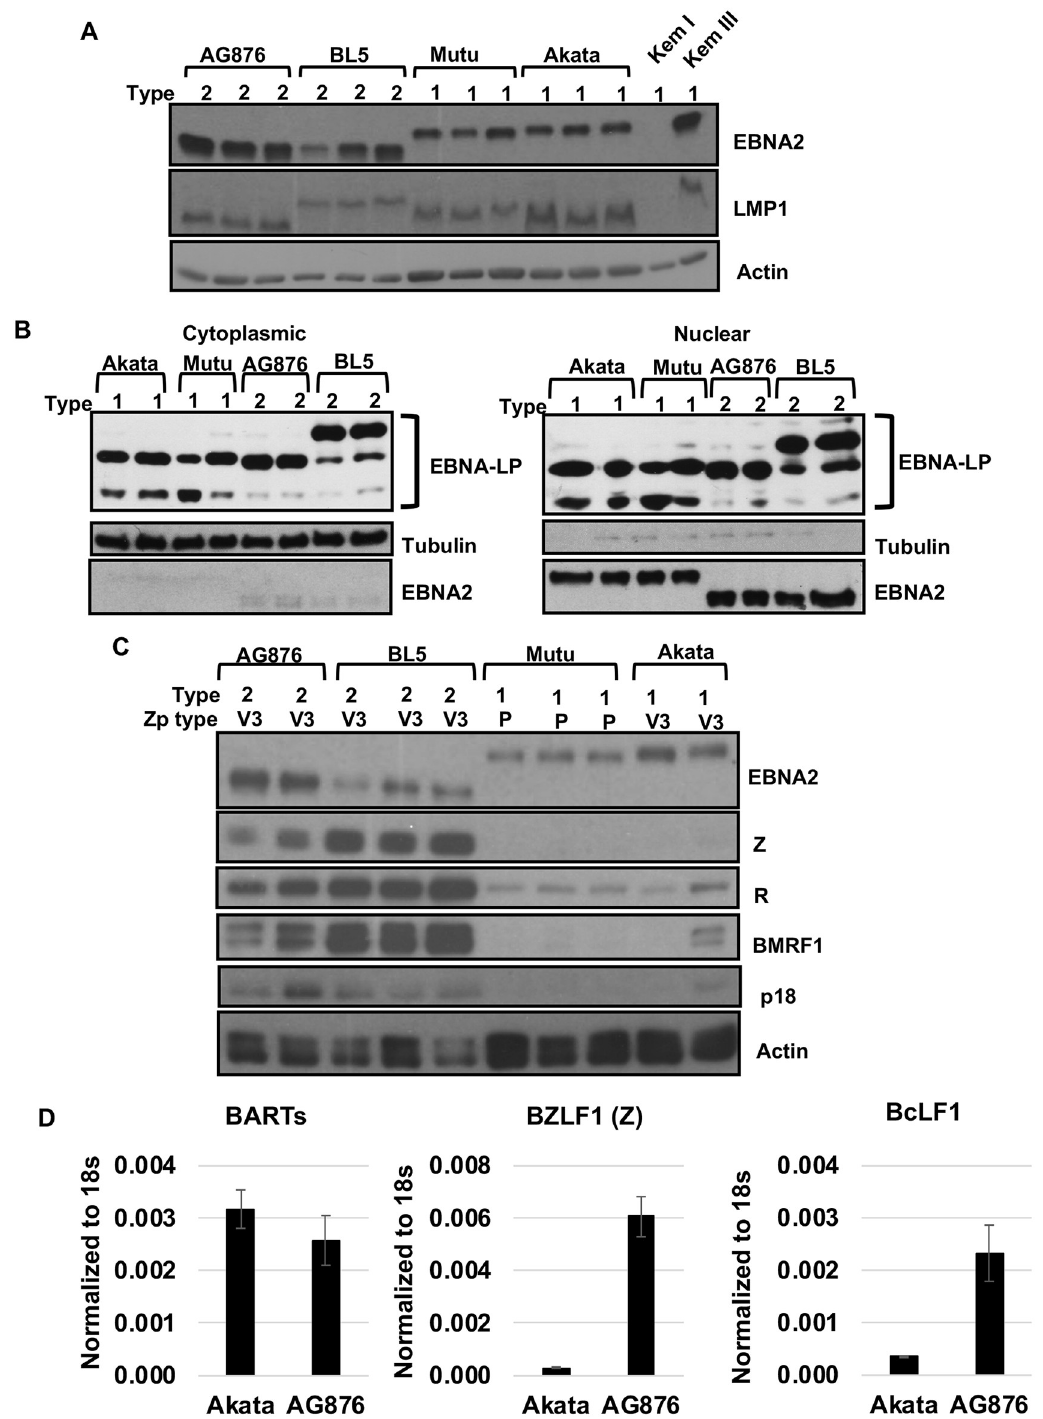
Fig 6. T2 EBV-infected LCLs have increased lytic infection compared to T1 EBV-infected LCLs. A) Immunoblot analysis of LCLs (from the same donor) derived from two different T1 strains (Akata and Mutu) and two different T2 strains (AG876 and BL5) was performed using antibodies against EBNA2 (EBV latency protein), LMP1 (EBV latency protein), and actin. Kem I and Kem III serve as negative and positive controls, respectively, for presence of EBNA2 and LMP1. B) Nuclear and cytoplasmic extracts from T1 and T2 EBV-infected LCLs were subjected to immunoblot analysis using antibodies against EBNA-LP, Tubulin (cytoplasmic fraction control), and EBNA2 (as a nuclear fraction control). C) Immunoblot analysis of LCLs using